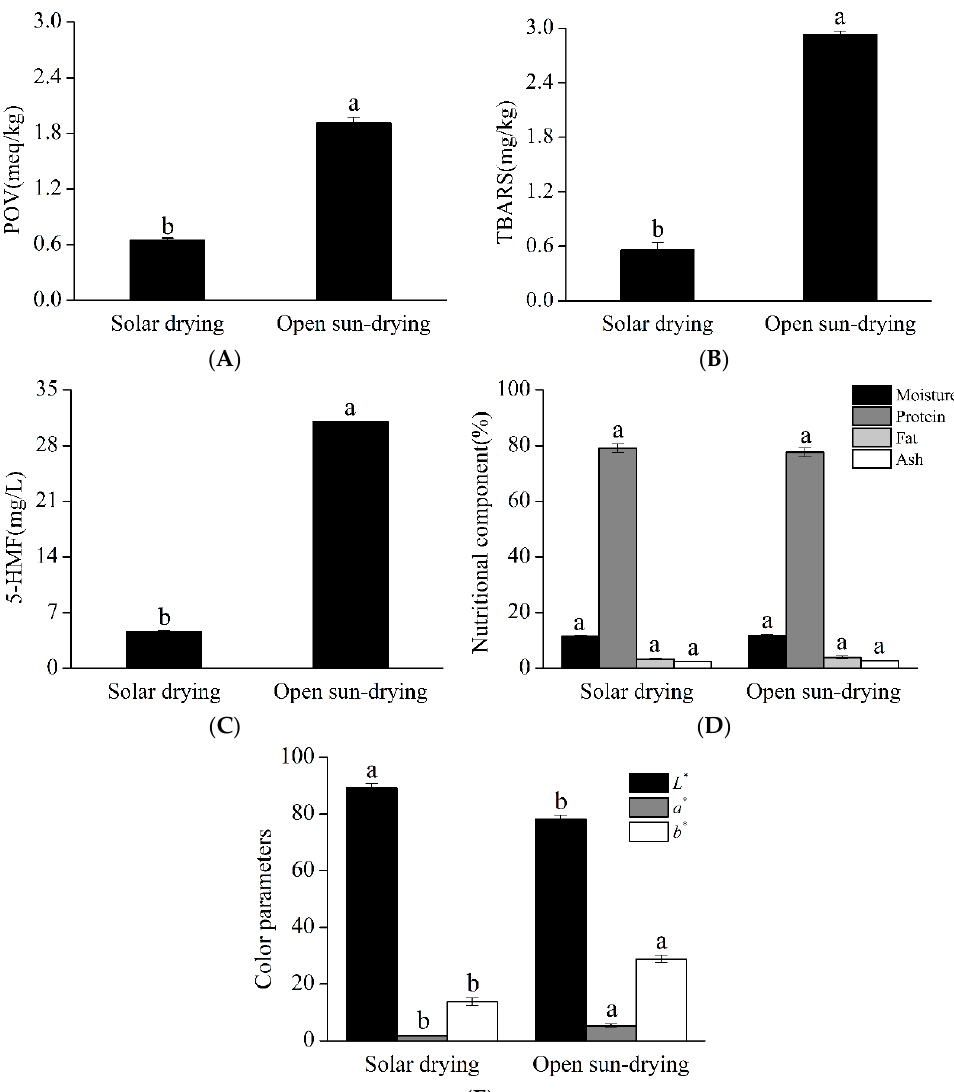
Figure 5. Quality comparison of Qula from solar drying and open sun-drying drying methods. Rep- resentative histograms showing the changes in the POV values ( A ), changes in the TBARS values ( B ), and changes in the 5-HMF contents ( C ); changes in the nutritional components ( D ) and color quality ( E ). a,b Means in the same color column with different superscripts differ significantly ( p < 0.05).